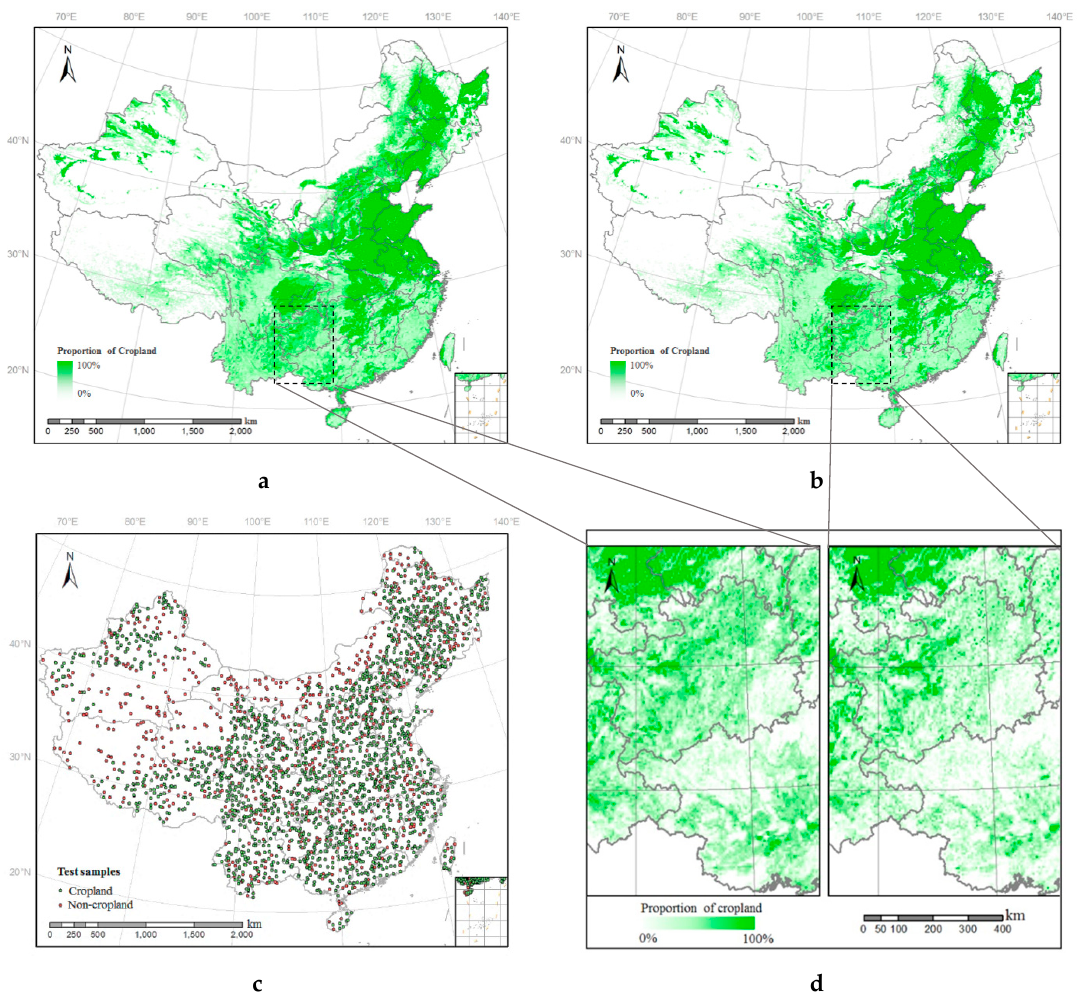
Figure 6. ( a ) The synergy cropland product generated by the model through fusion based on the direct arithmetic average method (MDAA). ( b ) The synergy cropland product generated by the model through fusion based on the overall consistency difference (MOCD). ( c ) Spatial distribution of the test samples. ( d ) Local zoomed maps of (a) and (b).